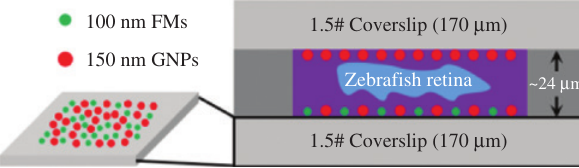
Figure 6: Zebrafish retina sample. Red balls are 150 nm diameter gold nanoparticles, and green balls are 100 nm diameter fluorescent